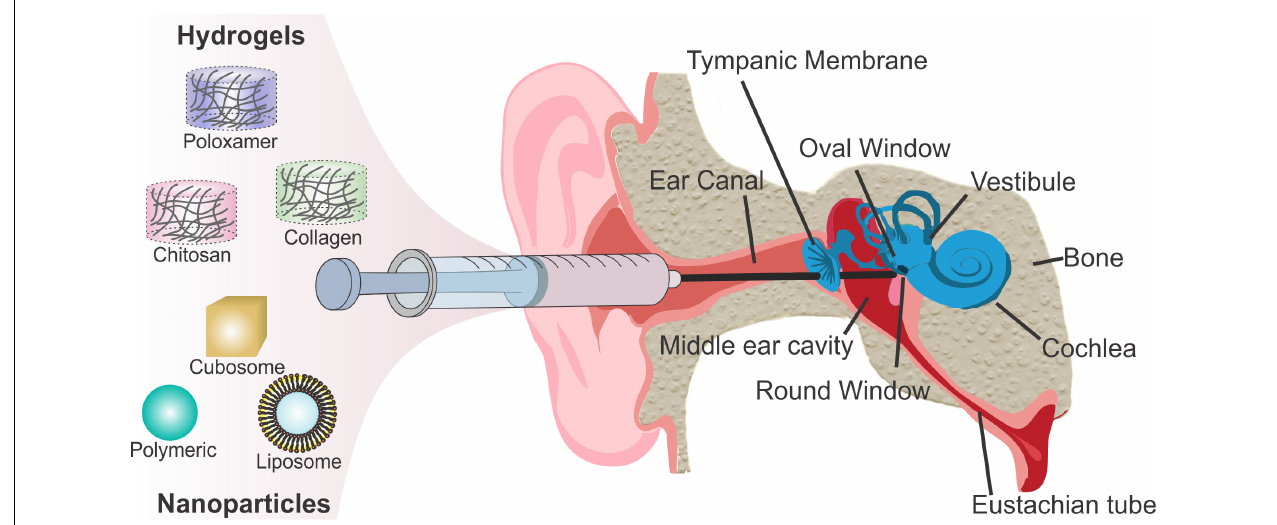
FIGURE 1 | Scheme of intratympanic injection of biomaterials to the round window for inner ear therapy.